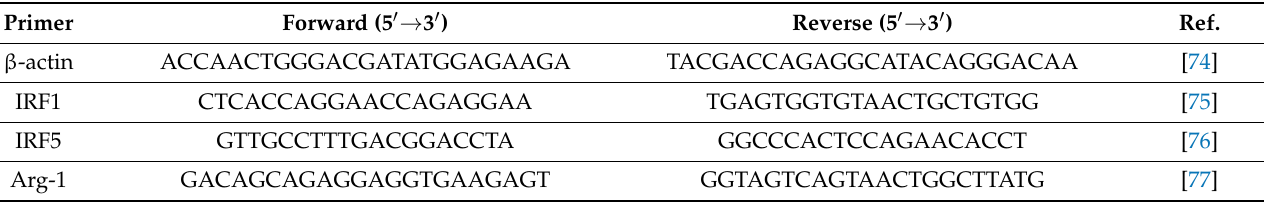
Table 1. Primers for Real-Time